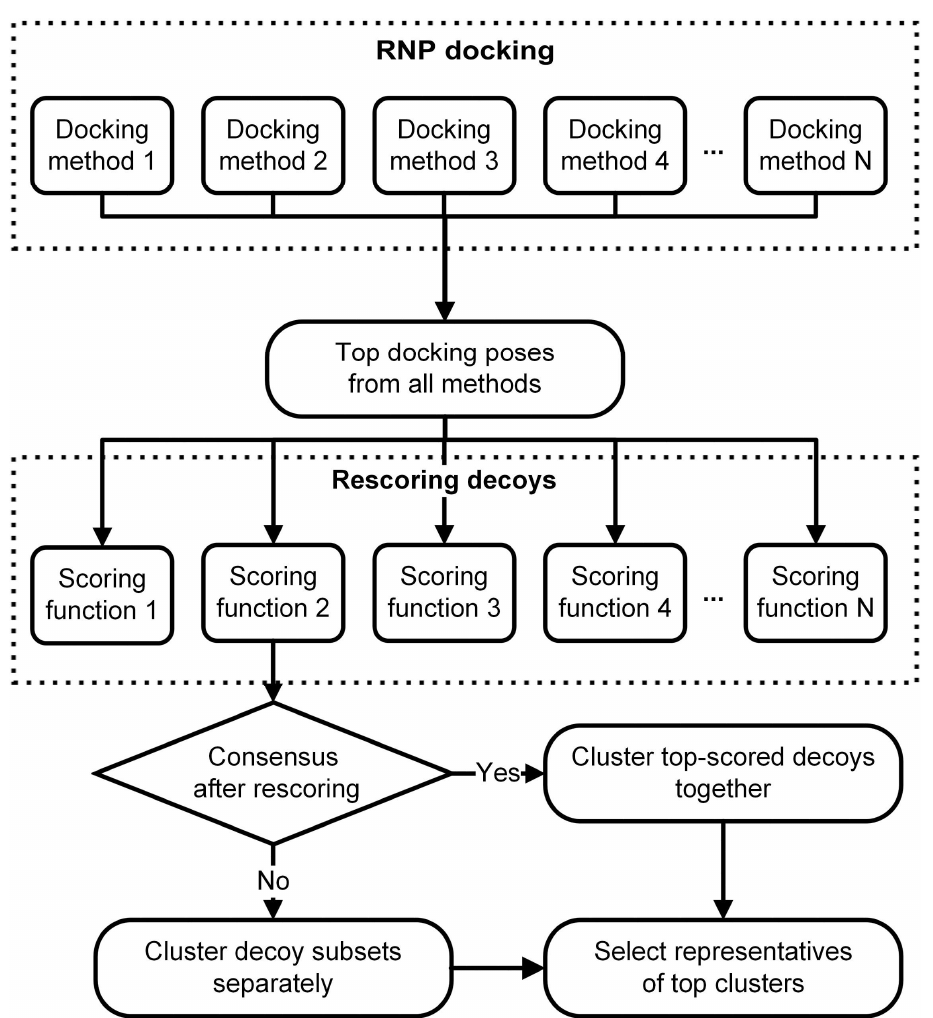
Figure 4. Schematic representation of the workflow for RNP docking. The docking strategy presented here combines the strengths of several docking and scoring methods.